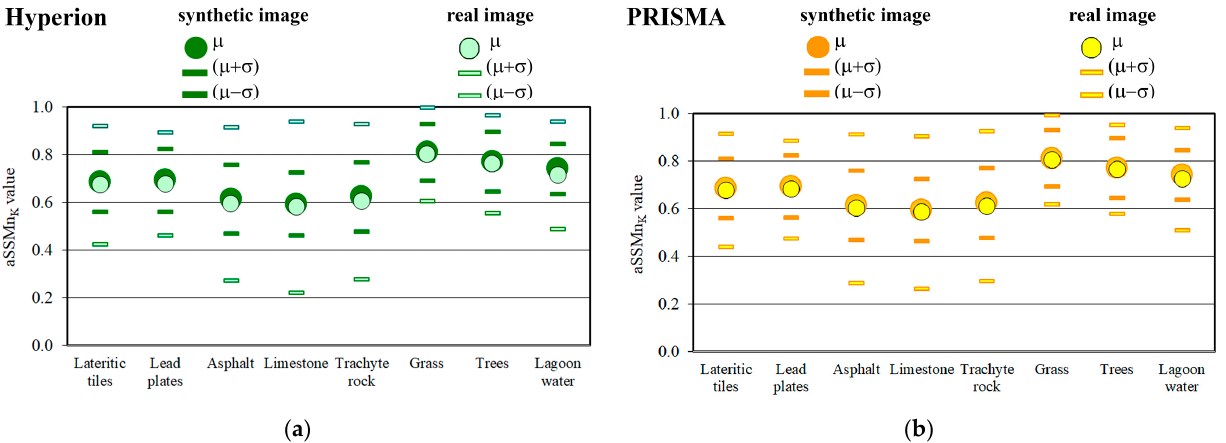
Figure 6. The comparison of the aSSMn k values (i.e., mean values and mean values plus and minus standard deviation values) evaluated from real and synthetic images: ( a ) the values obtained from Hyperion images; ( b ) the values obtained from PRISMA images.